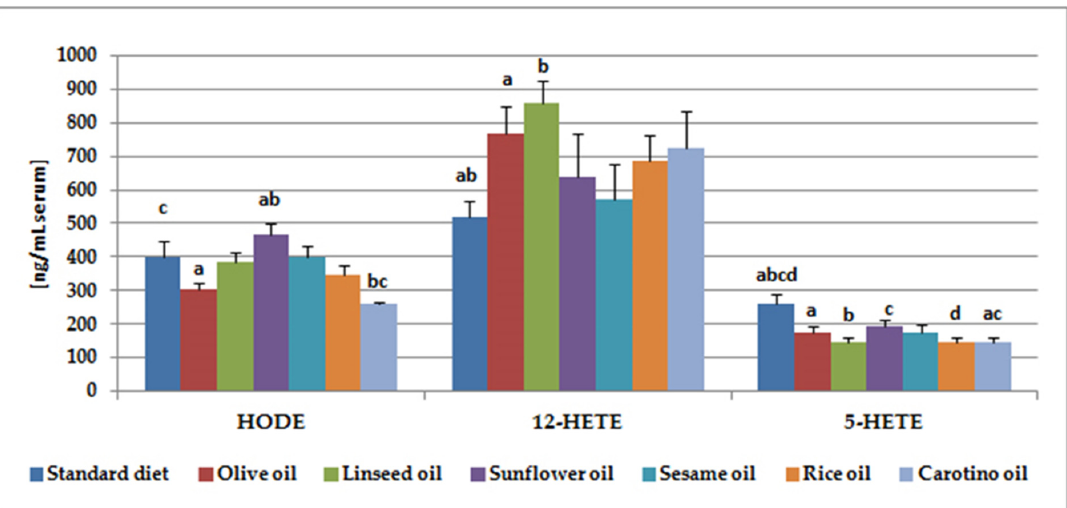
Figure 3. Contents of selected fatty acid metabolites in serum of rats supplemented with edible oils (ng/mL serum) . Data were expressed as mean values ± standard error of mean. Bars with the same superscript (a, b, c, or d) above referring to one metabolite are significantly different ( p < 0.05). Table 5. Correlation coefficients (r) between linoleic and arachidonic acid contents and their metabolites in rat serum